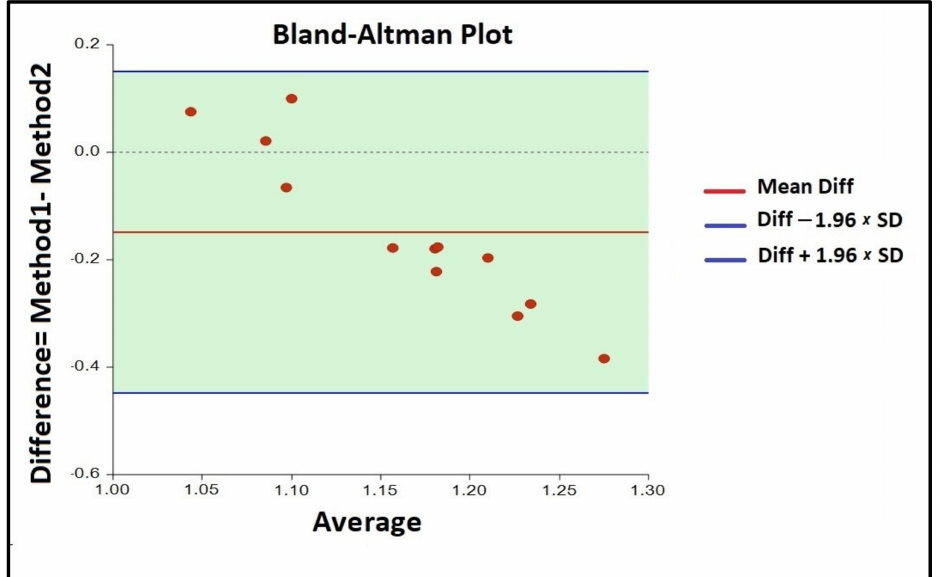
Figure 2. Bland–Altman plot for data from the Table 4, with the representation of the limits of agreement (blue line) from minus 1.96 × SD to + 1.96 ×